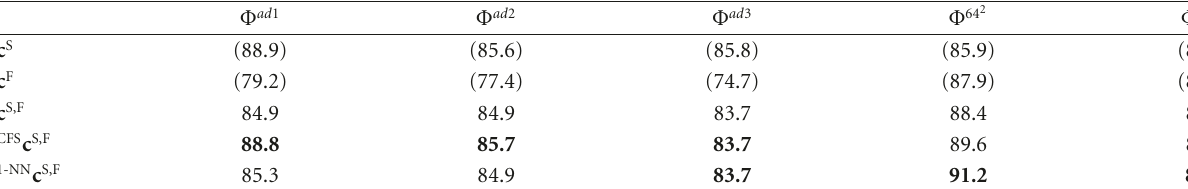
Table 2: Rates C P of correctly classified patterns for the five image sets Φ ad 1 , Φ ad 2 , Φ ad 3 , Φ 64 2 , and Φ 128 2 for the most appropriate Fourier and stripe feature sets as far as a 1-NN classifier is used, see the rates shown by an ∗ in Tables 6 and 7. Classification rates for the five images sets using the combined stripe and Fourier features c S,F . Classification rates after the selection of the most relevant features by means of a